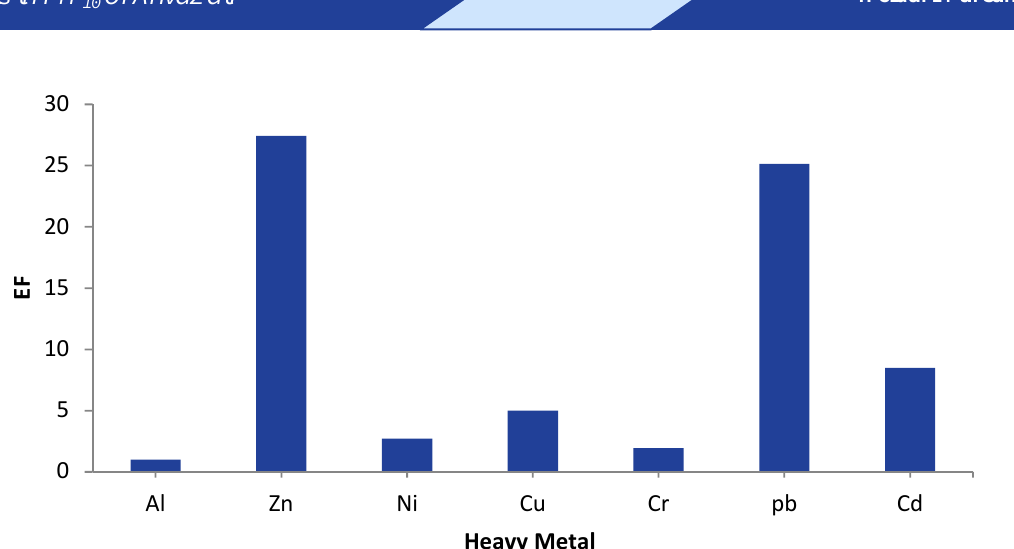
Figure 2. Enrichment factors (EFS) distribution for the heavy metals in the ambient air of Ahvaz city,